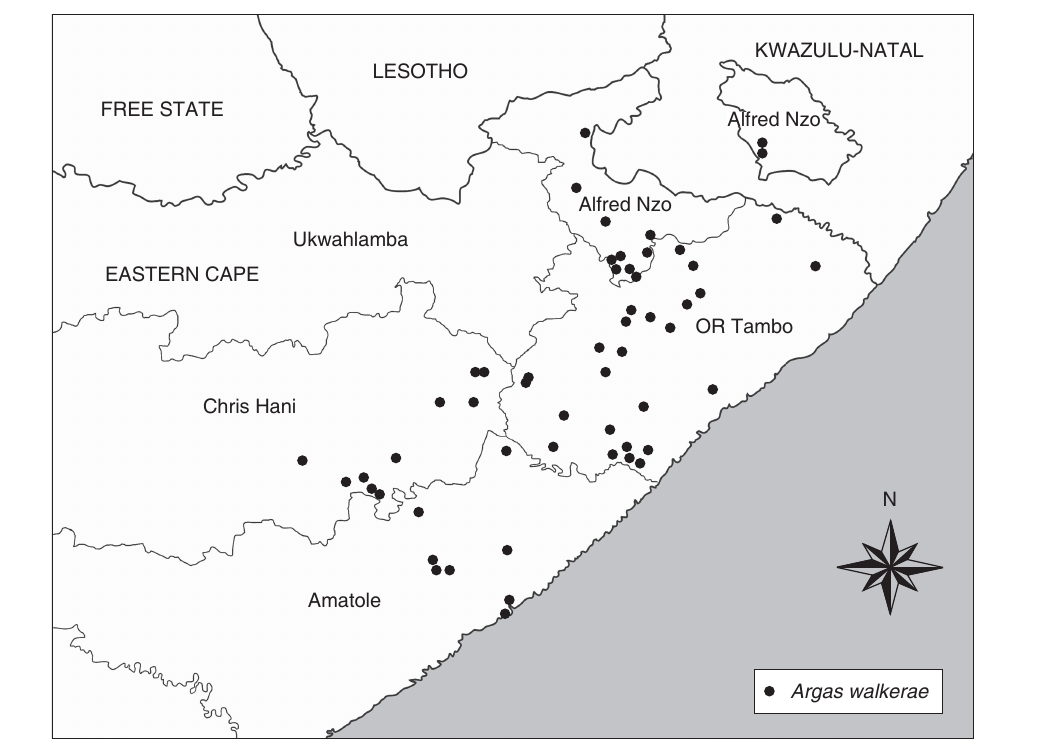
FIG. 1 The geographic distribution of cattle dip-tanks in the eastern region of the East ern Cape Province, South Africa, in the neighbourhood of which Argas walkerae was collected from fowl